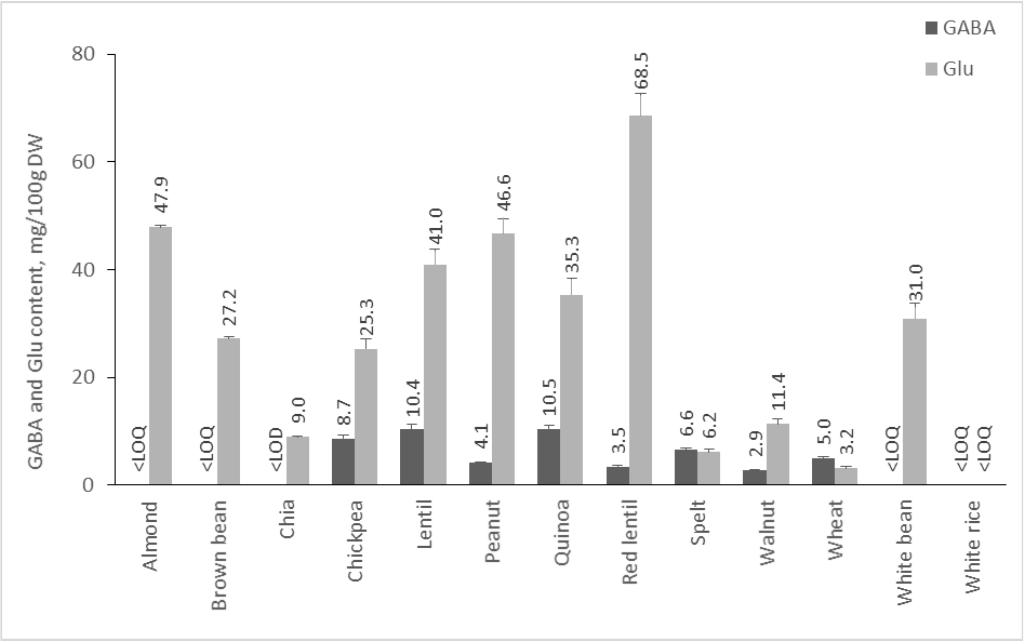
Figure 4. GABA and Glu content of cereals, pseudocereals, nuts, and legumes. Results are presented as mean values ± standard deviation (SD).